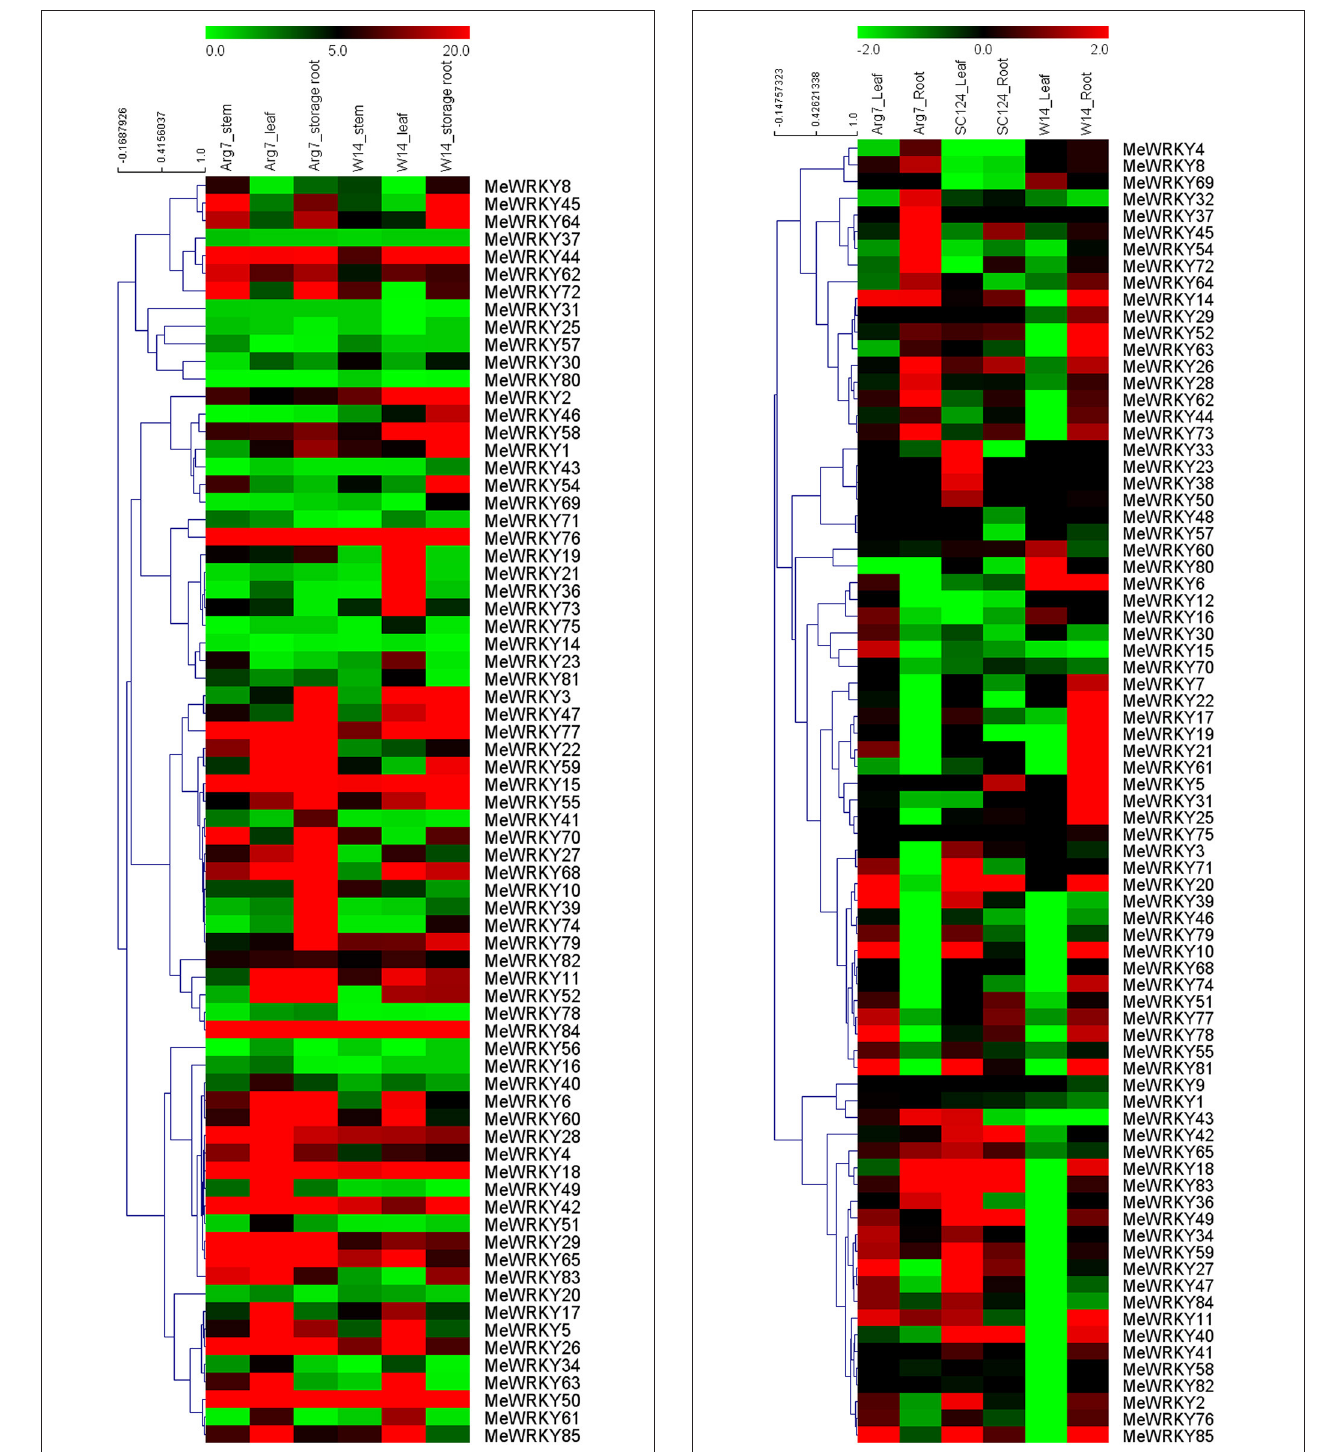
Frontiers in Plant Science | www.frontiersin.org